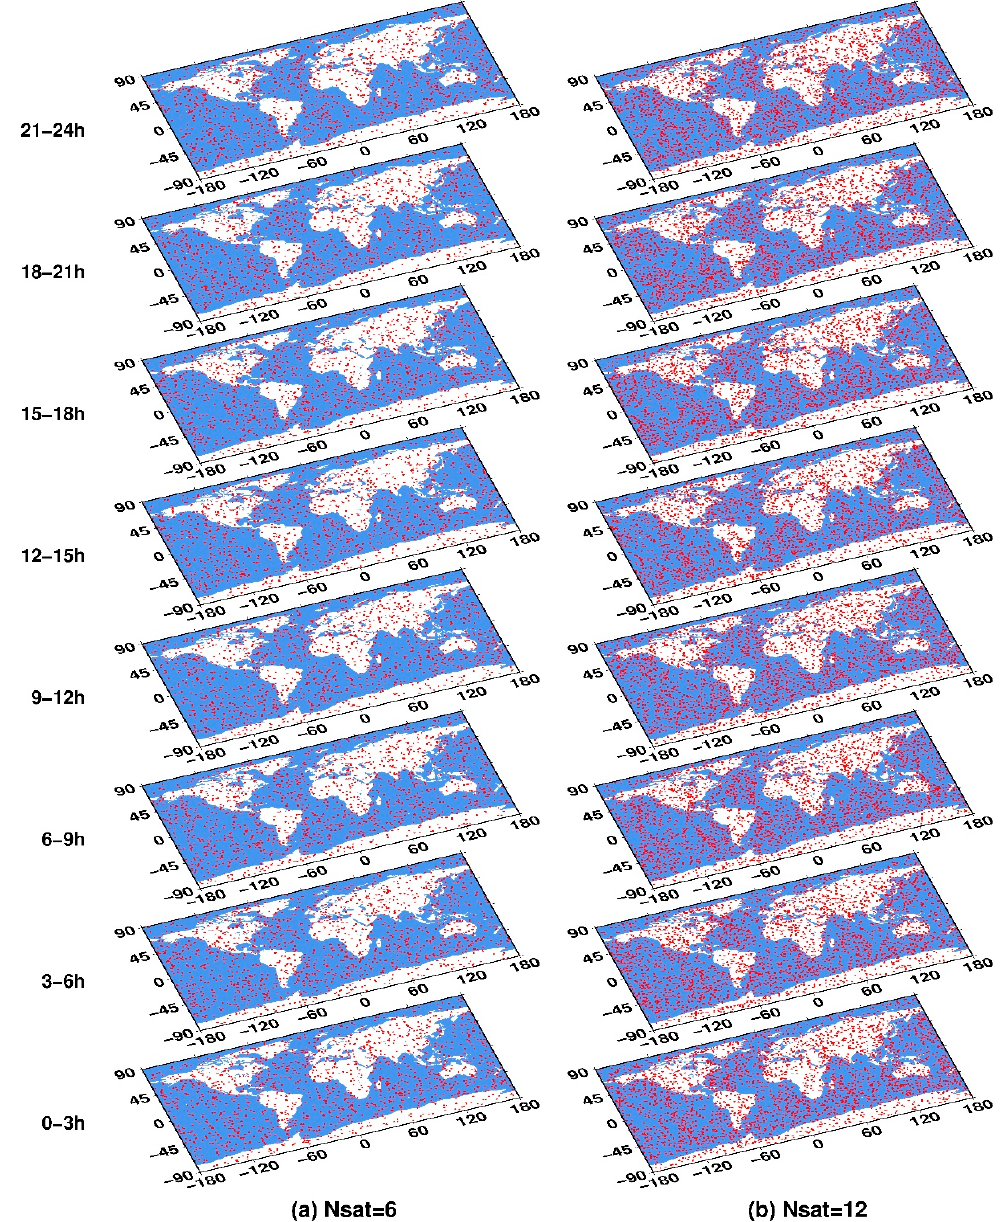
Figure 5. The distribution of ROEs observed within each three hours of one day by the final optimal LEO constellations with 2D-LFC pattern composed of 6 ( a ) and 12 satellites ( b ).